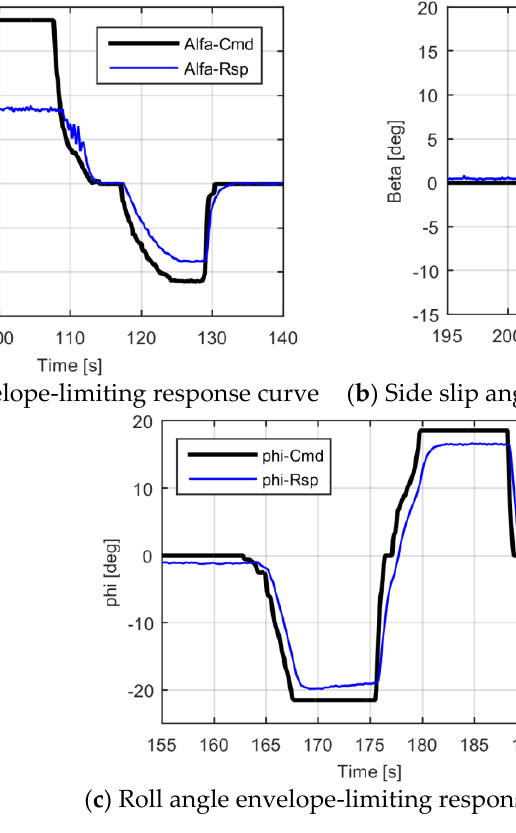
Figure 10. Background aircraft model attitude angle envelope-limiting response characteristic curve for heavy-icing configuration. ( a ) Attack angle envelope-limiting response curve. ( b ) Side slip angle envelope-limiting response curve. ( c ) Roll angle envelope-limiting response curve.